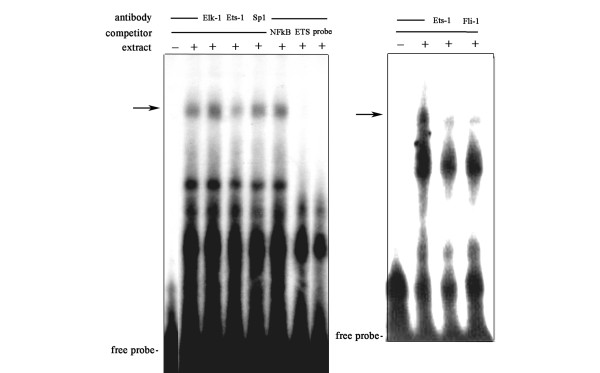
Ets-1 and Fli-1 bind the CCN2 promoter. A double-stranded oligomer corresponding to the -126 to -77 segment of the CCN2 promoter was used in a gel shift assay with NIH 3T3 fibroblast nuclear extract (5 μg) in the presence or absence of 100-fold molar excess of specific competitor corresponding to unlabeled probe (probe), or competitors corresponding to a consensus ETS (ETS) or NFκB binding site, or a 1 h pre-incubation with specific anti-Ets-1 antibody (Ets-1), anti-fli-1 (Fli-1), anti-Elk-1 (Elk-1) or anti-Sp1 (Sp1) antibody. Location of the free probe and shifted Ets-1 containing complex (arrow) are indicated. Representative gel shift assays are shown (N = 3).